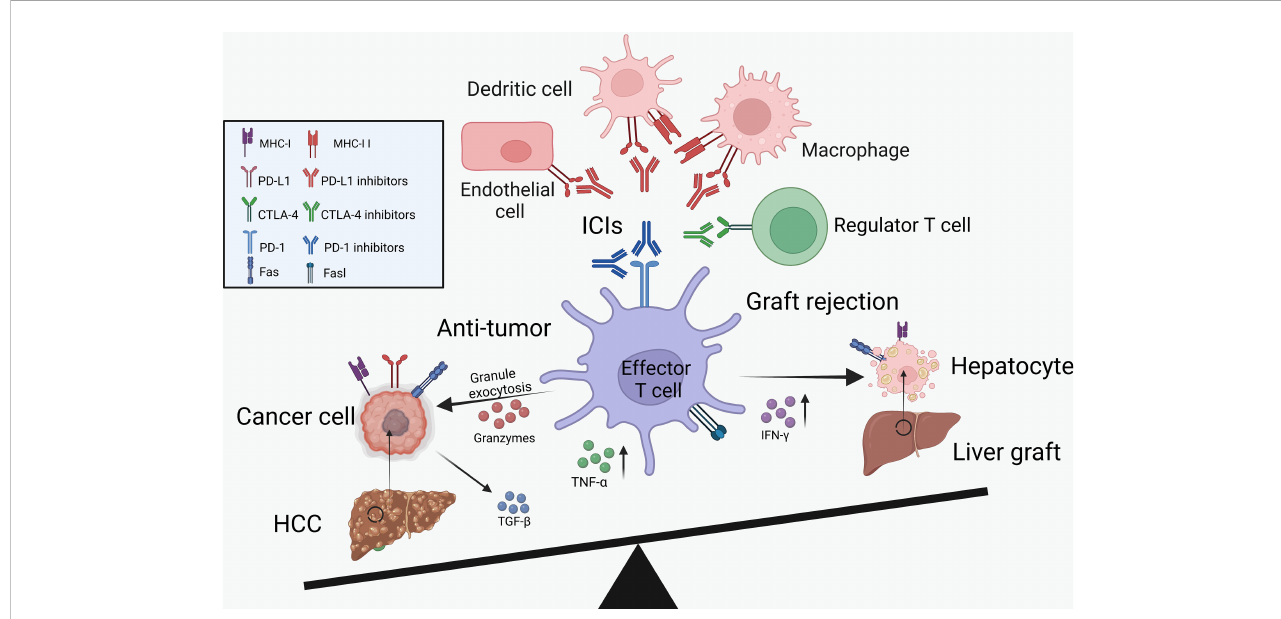
FIGURE 1 The balance between cancer immunology and transplant tolerance. Through the activation of effector T cells, the ICIs can not only reduce tumor burden but also increase the risk of graft rejection. IL-2, interleukin-2; IFN- g , interferon- g ; TNF- a , tumor necrosis factor- a